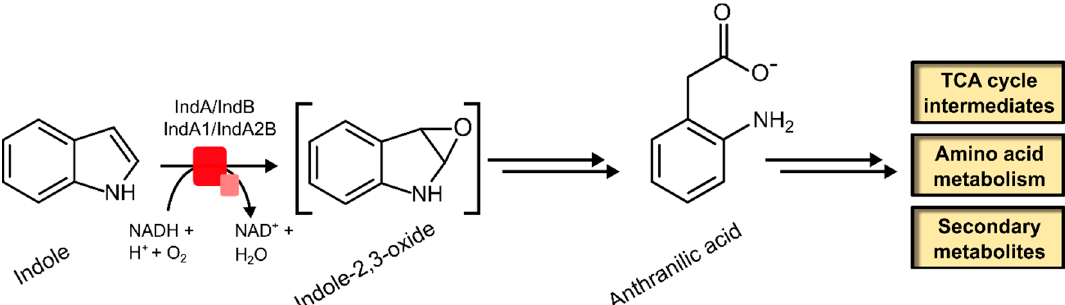
Table 2. Representatives of Group